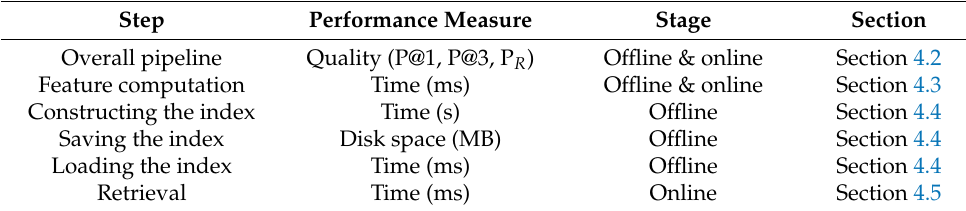
Table 2. Considered performance